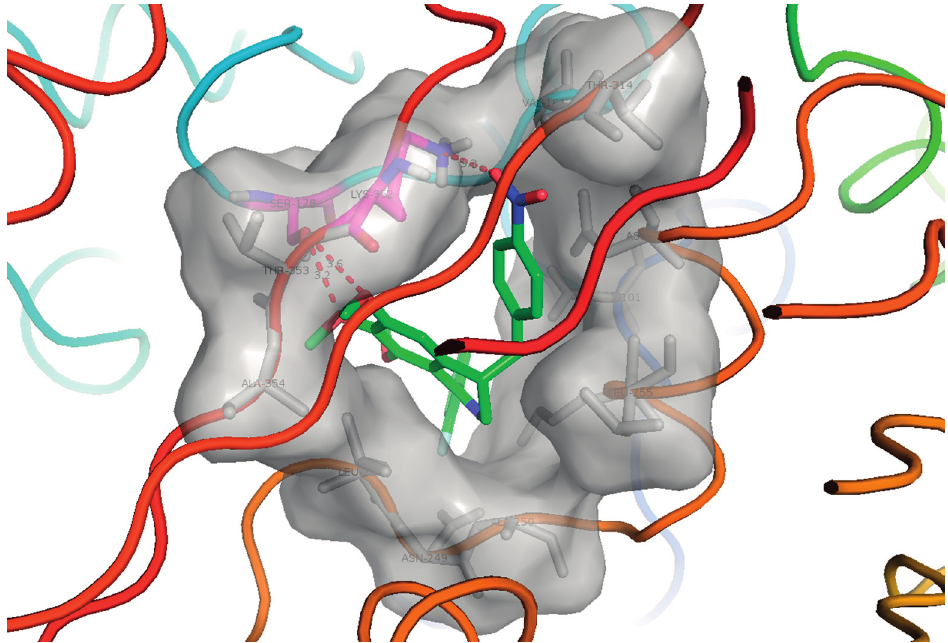
Figure 4. The hypothetical binding mode of the S isomer of compound 32 to tubulin protein. P1 and P2 are the two hydrophobic pockets, and P3 is a polar region in the interface between α / β -tubulin. The figure was generated using PyMol